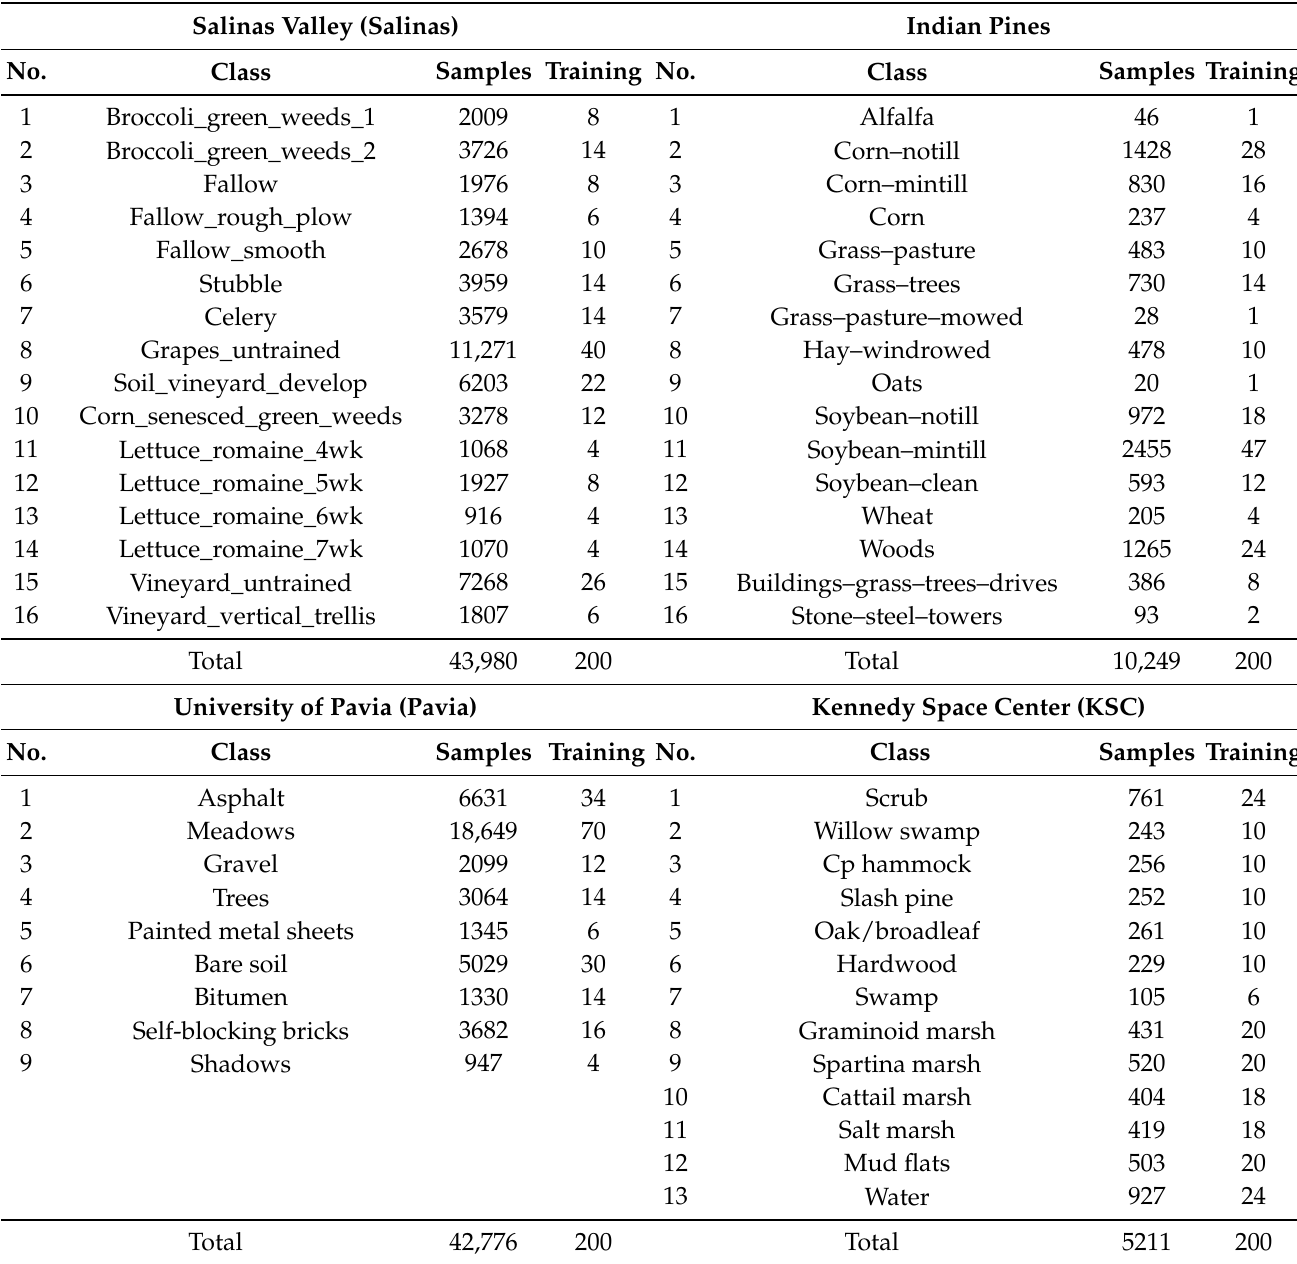
Table 1. Number of samples in the Salinas Valley (Salinas), Indian Pines, University of Pavia (Pavia), and Kennedy Space Center (KSC) hyperspectral